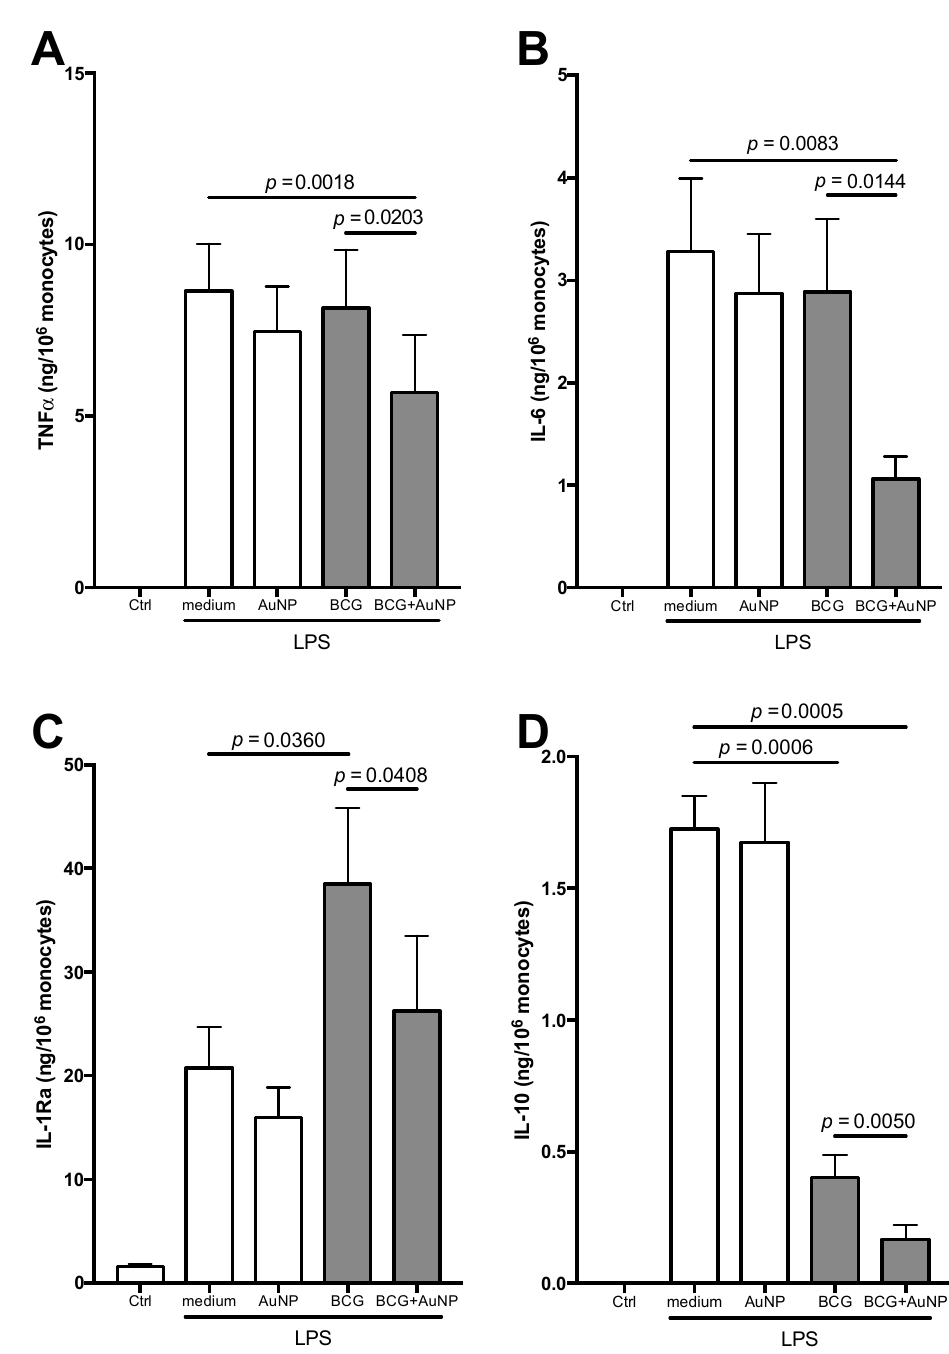
Figure 6. Secondary response of human monocytes primed with BCG and AuNP. Following primary activation (in x-axis: medium, AuNP, BCG, BCG + AuNP), cells were rested for 6 days and then challenged with LPS (5 ng/mL) for 24 h. Production of TNF α ( A ), IL-6 ( B ), IL-1Ra ( C ) and IL-10 ( D ) was measured in the culture supernatants after 24 h. Priming conditions are indicated on the x-axis, and Ctrl represents the response of cells challenged with medium (the response was identical in cells previously primed with medium, AuNP, BCG or BCG + AuNP). Results are reported as mean ± SEM of data from 2–4 individual donors, tested in separate experiments. Further, p values are indicated when p < 0.05. Although statistically significant, we have not reported in the figure the differences between AuNP and BCG ( p = 0.0051 for IL-1Ra, and p = 0.0145 for IL-10) or between AuNP and BCG + AuNP ( p = 0.0449 for TNF α , p = 0.0056 for IL-6, and p = 0.0077 for IL-10).